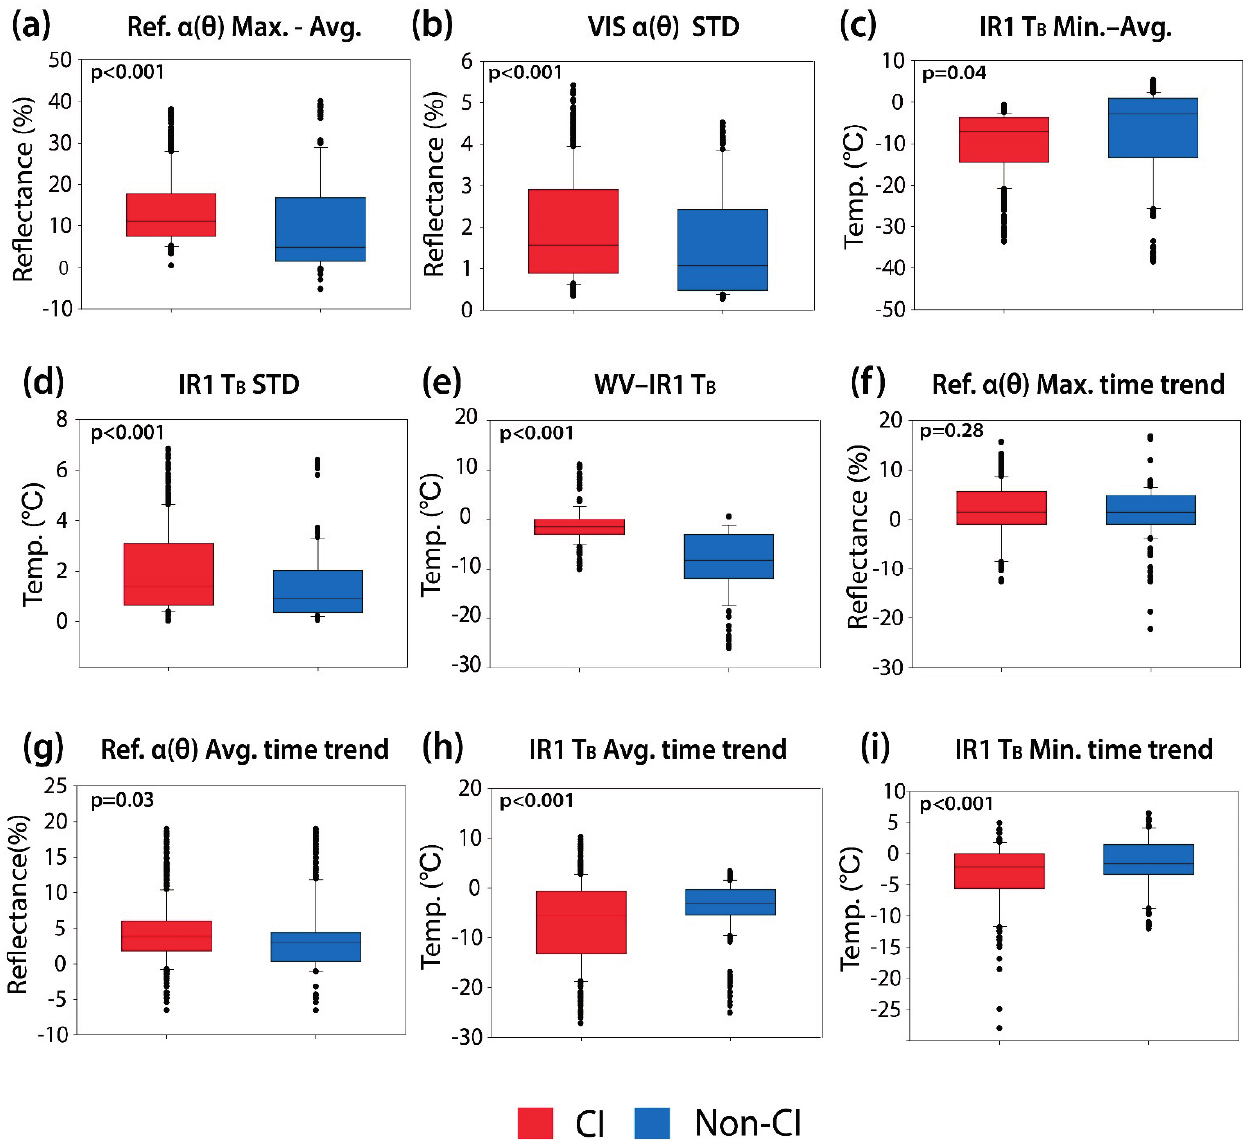
Figure 2. Box plots of the interest fields used for CI detection: ( a ) VIS (cid:2745)(cid:4666)(cid:2752)(cid:4667) Max.–Avg., ( b ) VIS (cid:2745)(cid:4666)(cid:2752)(cid:4667) STD, ( c ) IR1 T B Min.–Avg., ( d ) IR1 T B STD, ( e ) WV–IR1 T B , ( f ) VIS (cid:2745)(cid:4666)(cid:2752)(cid:4667) Max. time trend, ( g ) VIS (cid:2745)(cid:4666)(cid:2752)(cid:4667) Avg. time trend, ( h ) IR1 T B Avg. time trend, and ( i ) IR1 T B Min. time